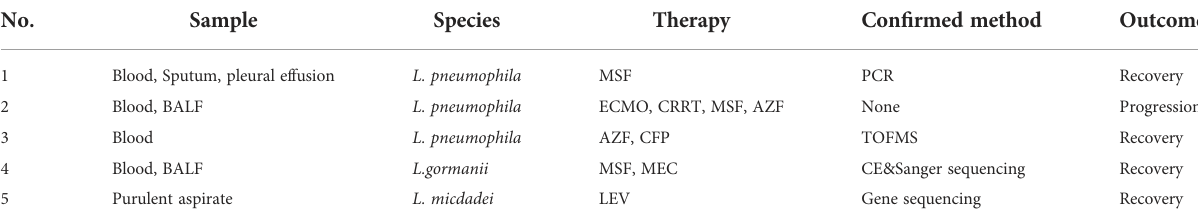
TABLE 4 Type of sample, species, therapy, con fi rmation method, and outcome of 5 patients previously diagnosed with Legionella infections based on mNGS. No.